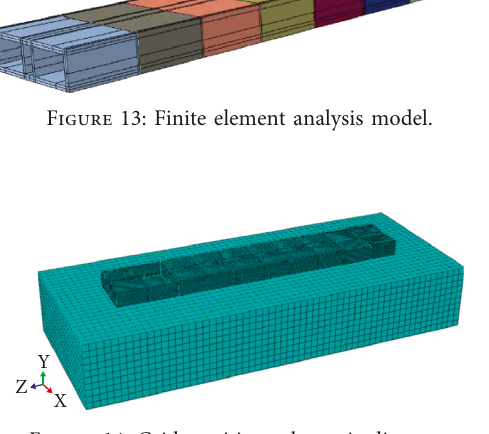
Figure 14: Grid partition schematic